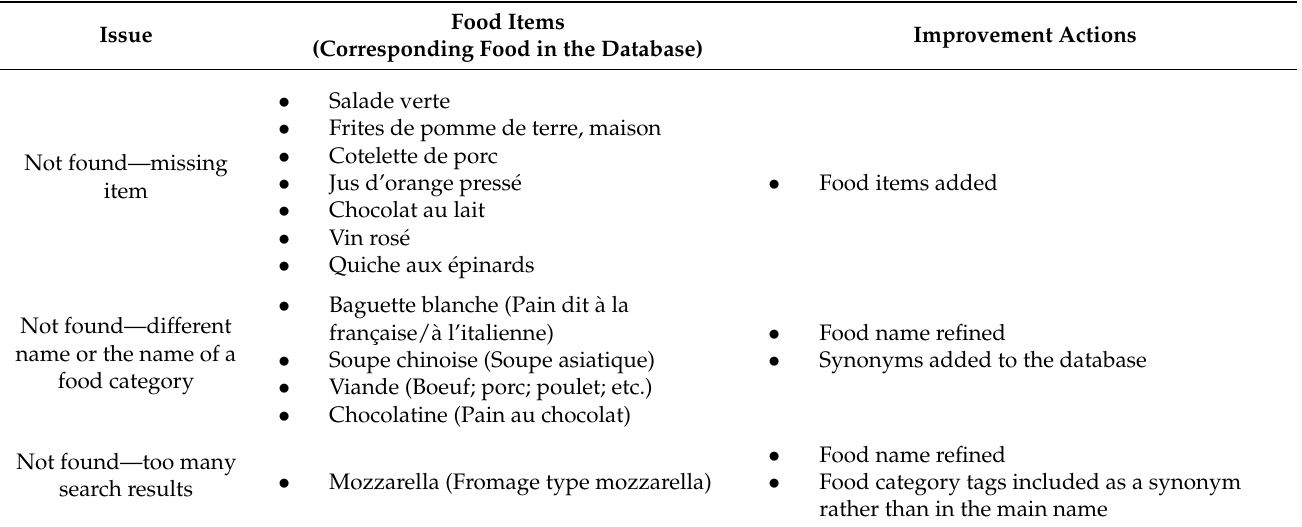
Table 2. Feedback provided on the database during usability testing and the actions for